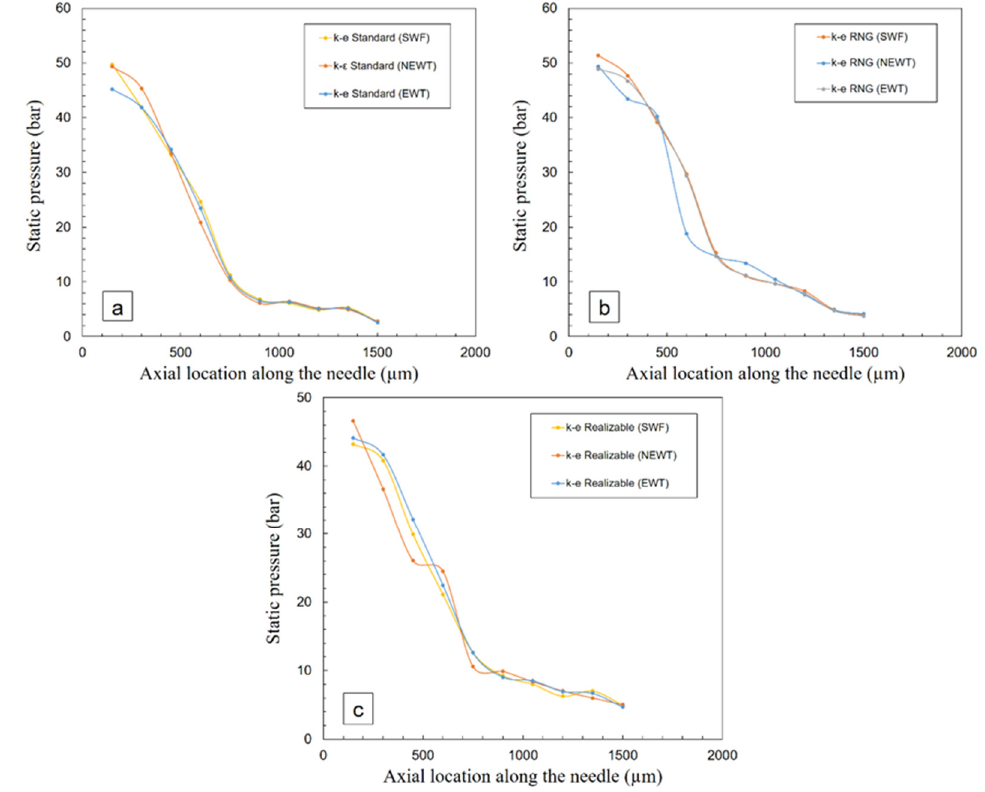
Figure 7. The effect of wall treatment on wall static pressure at the inlet pressure of 50 bar for tip clearance of 200 µm for ( a ) Standard k- ε model, ( b ) k- ε RNG model, and ( c ) k- ε Realizable model.